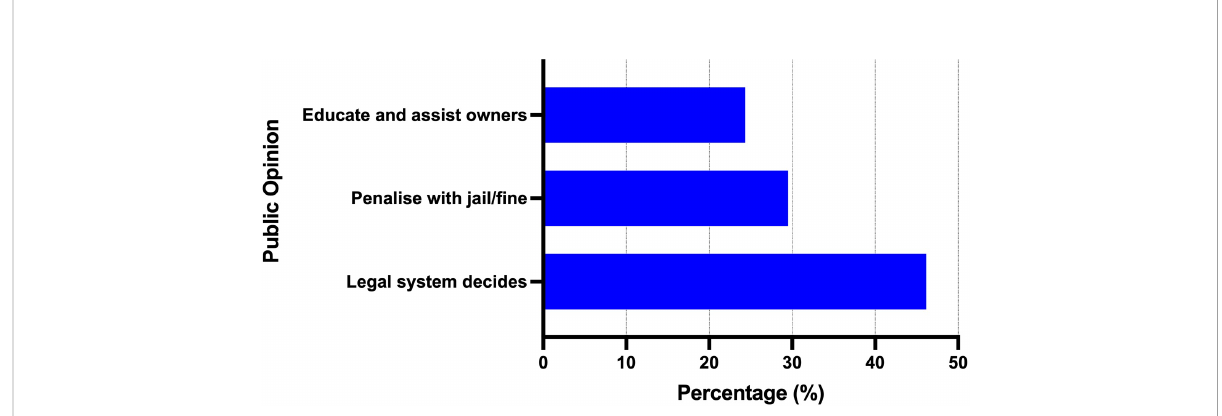
FIGURE 4 Percentages of responses towards alternative enforcement outcomes for animal cruelty investigations (n=2152). “ Do you think owners should be educated or punished when animal welfare issues occur (e.g. not taking your sick animal to the vet)? ” .